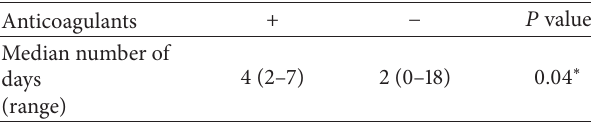
Table 5: Median days from endoscopic treatment to bleeding.